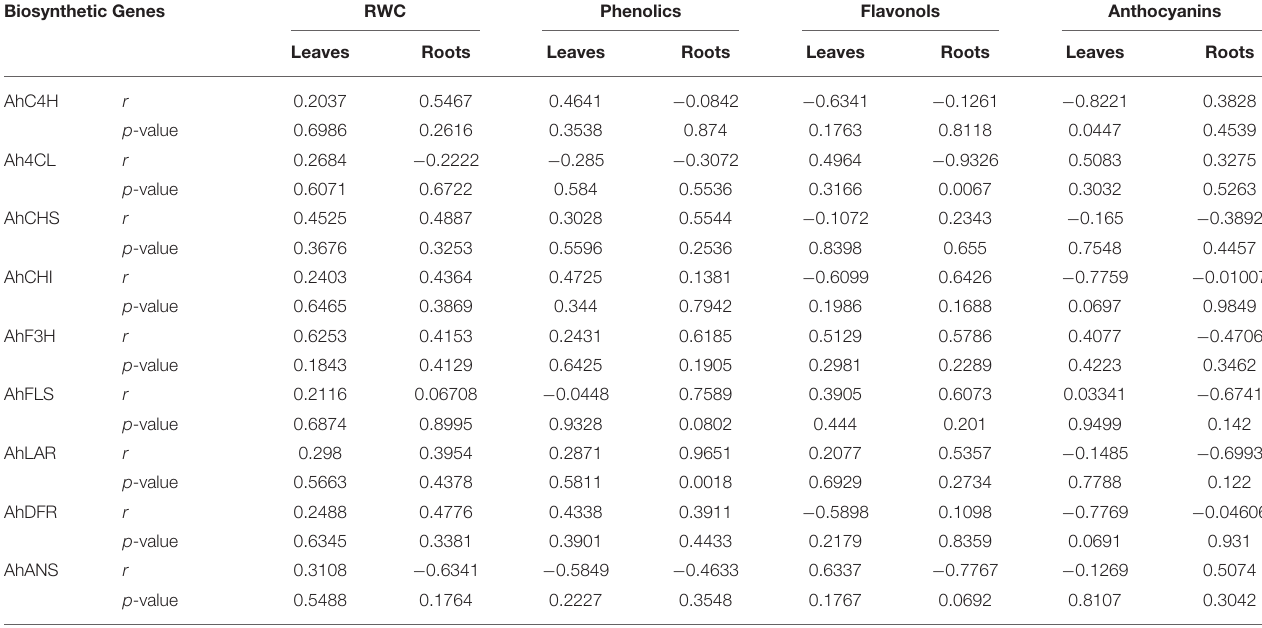
TABLE 3 | Correlation of flavonoid biosynthetic pathway gene expression with the accumulation of phenolics, flavonols, and anthocyanins in peanuts under water deficit conditions. Biosynthetic Genes